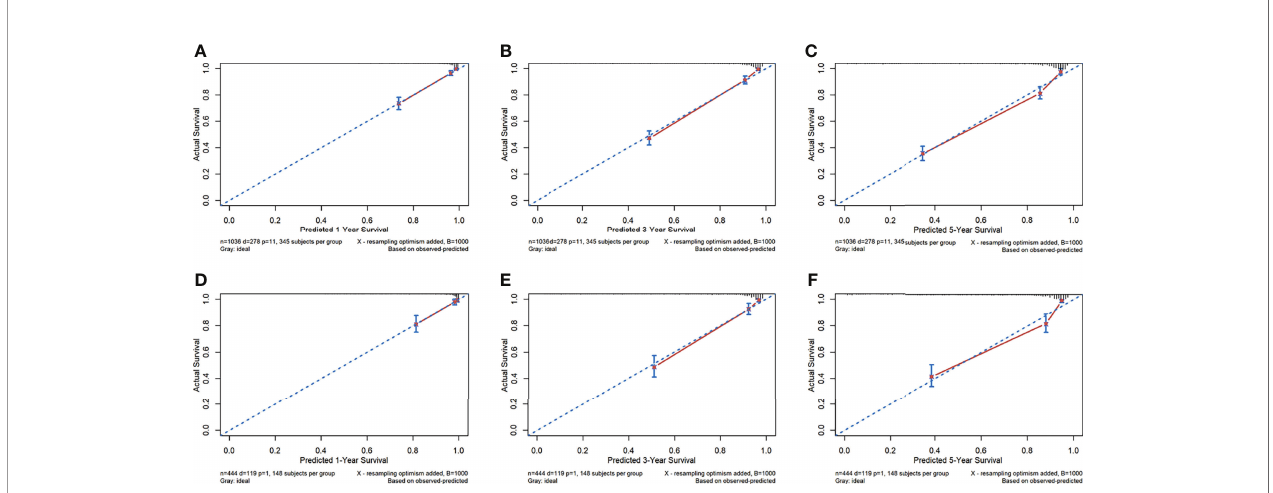
FIGURE 3 | The calibration curves of the radiomics nomogram. (A – F) Calibration curves for predicting patient survival in the training cohort at 1 year (A) , 3 years (B) , and 5 years (C) and in the validation cohort at 1 year (D) , 3 years (E) , and 5 years (F) . The overall survival predicted by the radiomics nomogram is on the x -axis, while the actual overall survival is on the y -axis. A graph drawn along the diagonal line represents the perfect prediction in which the predicted probabilities is exactly the same as the actual